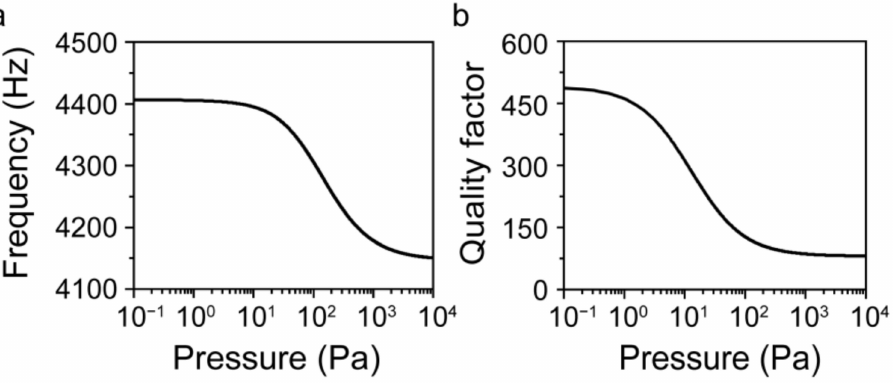
Figure 5. Resonant frequency and quality factor variation curve with air pressure. ( a ) Variation of resonant frequency with air pressure; ( b ) Variation of quality factor with air